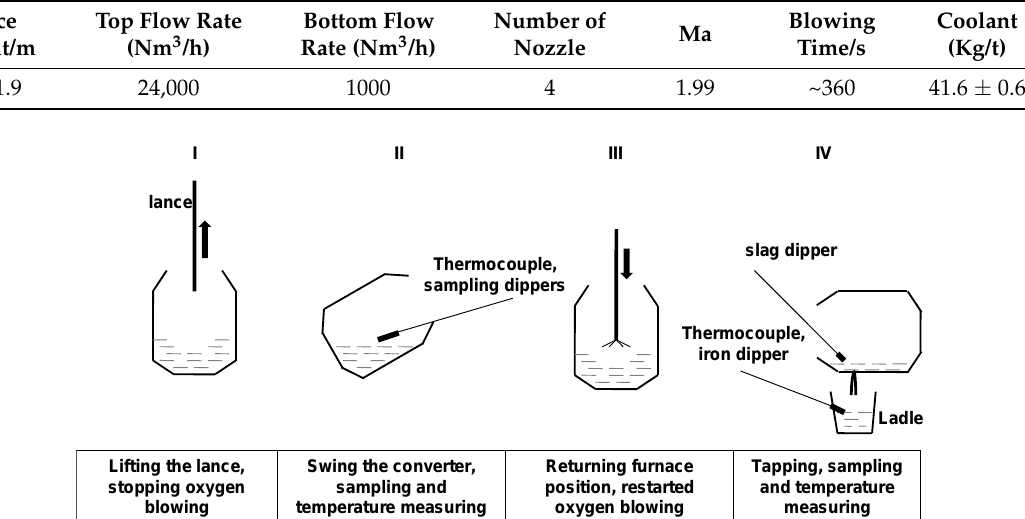
Figure 1. Schematic of sampling and temperature measuring operations.